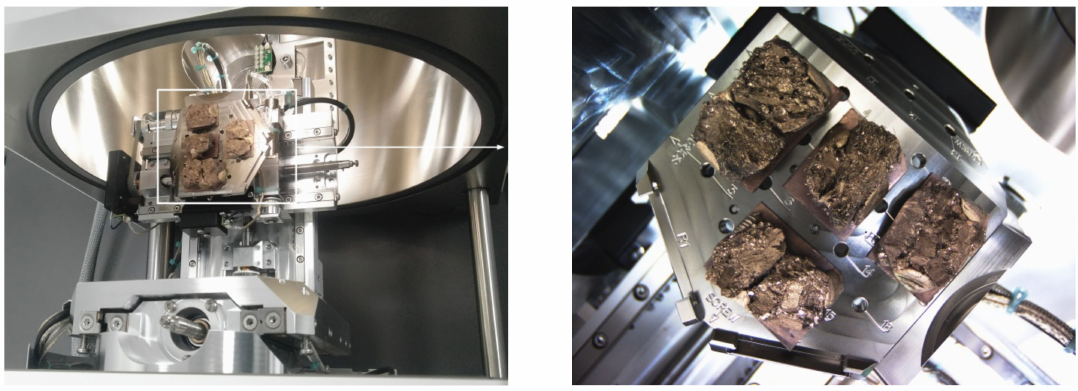
Figure 3. A small portion of the specimens placed onto the Apreo SEM scanning